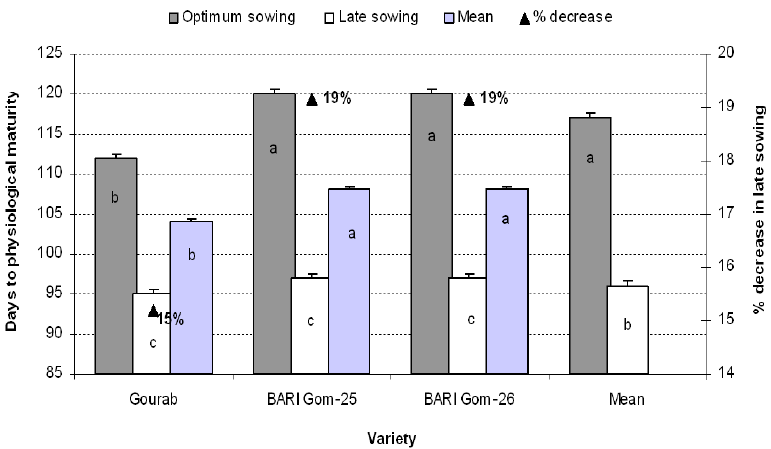
Fig. 7. Days passed to physical maturity of 3 wheat varieties when sown under op- timum and very late conditions. Mean (±SD) was calculated from three replicates for each treatment. Bars with different letters are significantly different at p ≤